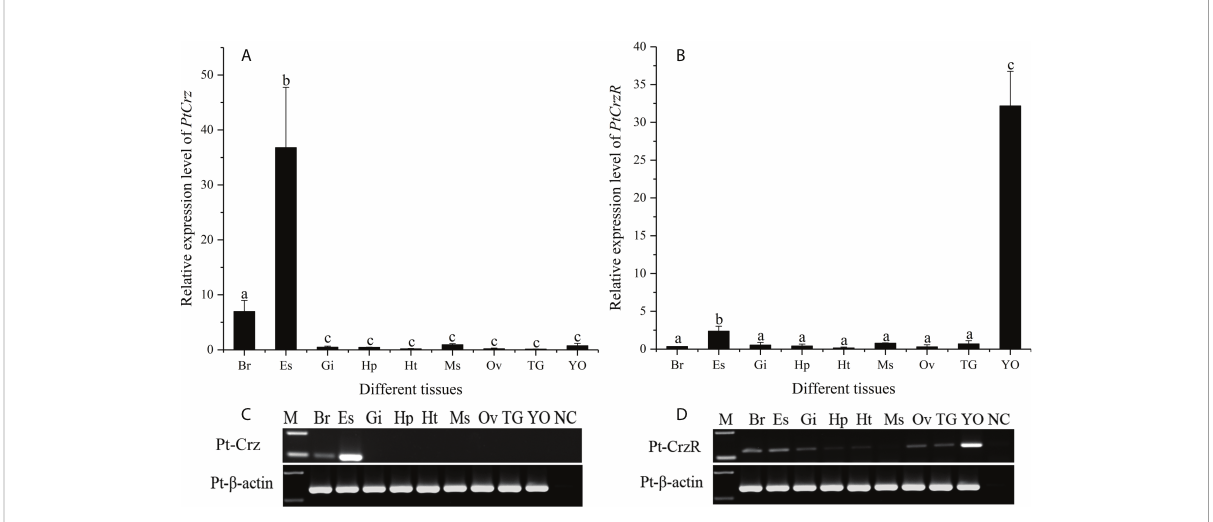
FIGURE 3 Tissue distribution of PtCrz (A, C) and PtCrzR (B, D) mRNA in the swimming crab (n=5). Different letters indicate statistically signi fi cant differences ( P < 0.05) within each tissue. Br, brain; Es, eyestalk ganglion; Gi, gill; Hp, hepatopancreas; Ht, heart; Ms, muscle; Ov, ovary; TG, thoracic ganglion; YO, Y-organ.